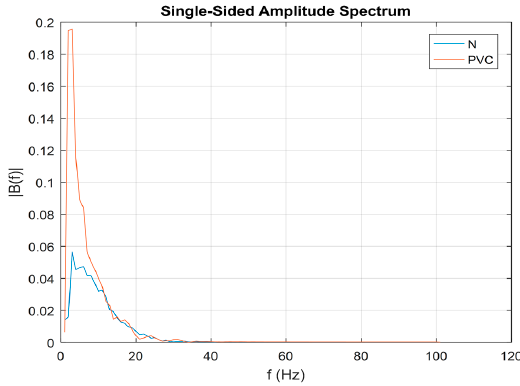
Figure 10. Single-sided amplitude spectrum of normal beat (blue) and PVC beat (red).